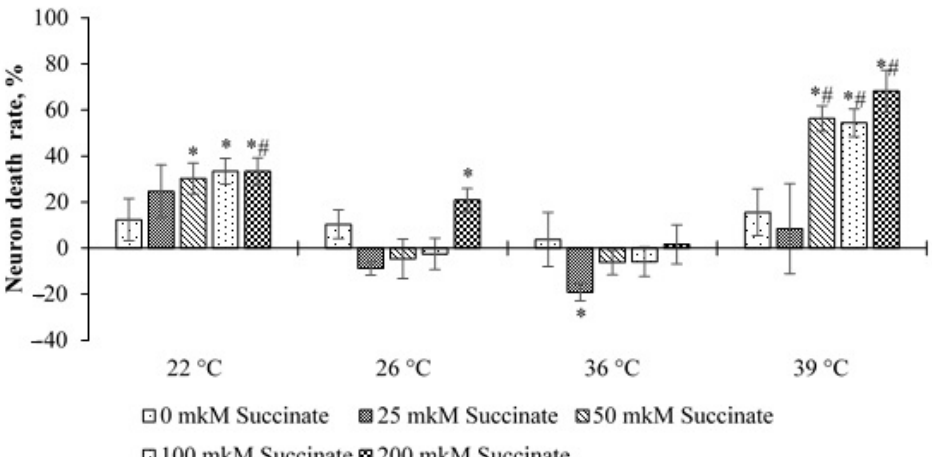
Figure 5. The death rate of cerebellum neurons depending on temperature and succinate concentration for ISS—50 ppm. Note: The values are compared in reference to points 150 ppm—0 μM. Data are represented by M ± m. * p < 0.05 in relation to the point of 150 ppm; # p < 0.05 is the comparison between points 150 and 50 with the same concentration of succinate. Note: 1—ISS is 50 ppm, 0 μM succinate; 2—ISS is 50 ppm, 25 μM succinate; 3—ISS is 50 ppm, 50 μM succinate; 4—ISS is 50 ppm, 100 μM succinate; 5—ISS is 50 ppm, 200 μM succinate.